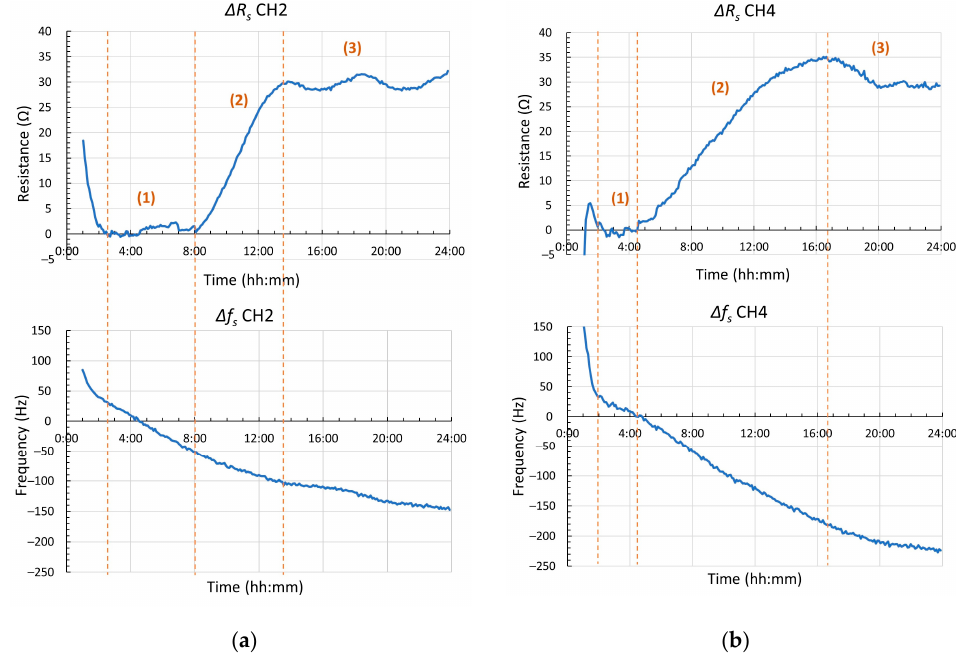
Figure 5. Resonance frequency shift, Δ f s , and resistance at resonance shift, Δ R m , in a 24-h experiment using a Staphylococcus aureus culture: ( a ) channel 2 and ( b ) channel 4. The different stages of biofilm formation and growth were identified in the graphs: ( 1 ) initial stabilization, ( 2 ) biofilm formation and growth, and ( 3 ) maturation.